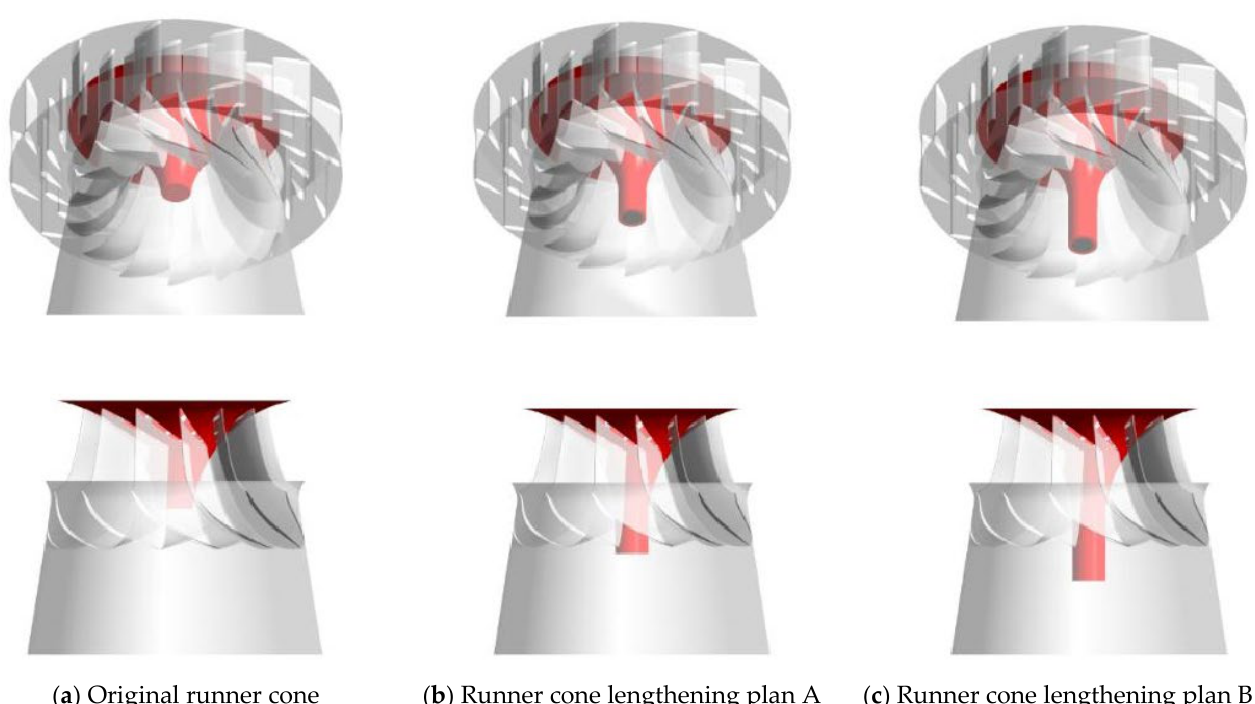
Figure 15. Extension scheme of runner cone [44].